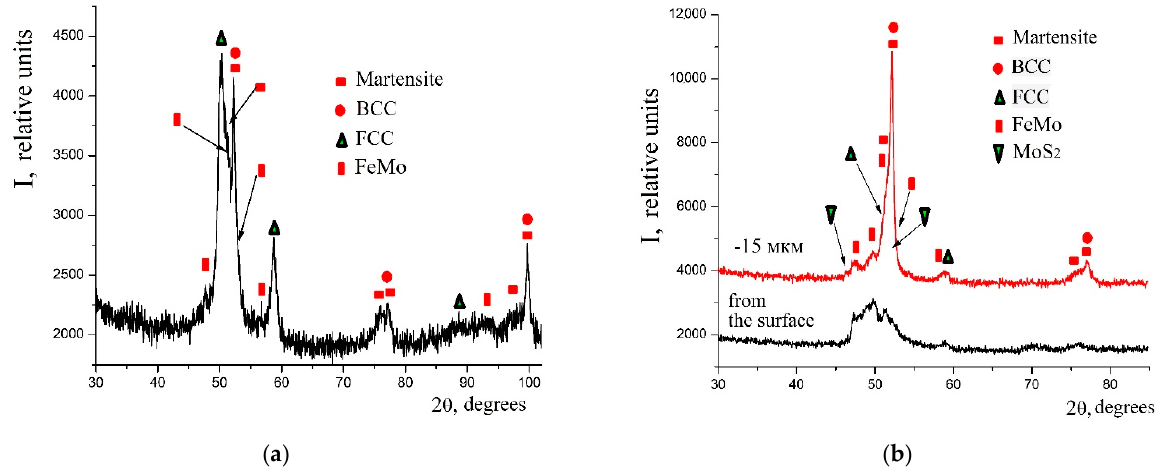
Figure 9. Diffractograms of sulfomolybdenum coatings obtained by ESA method on steel C40: ( a ) Wp = 0.13 J; ( b ) Wp = 3.4 J. Table 3. Parameters for crystal lattices of phases and quantitative phase analysis of the sulfomolybdenum coatings on C40 steel. Discharge Energy,